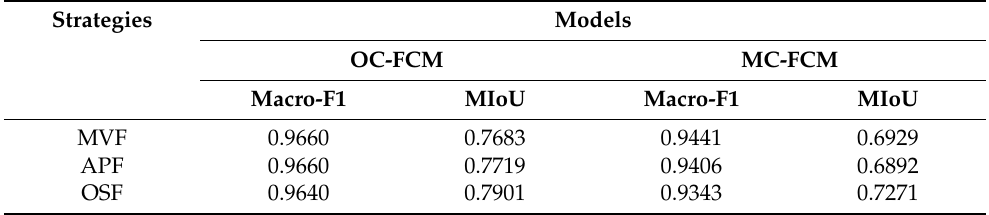
Table 6. Accuracy differences of OC-FCM and MC-FCM based on different fusion strategies. Strategies